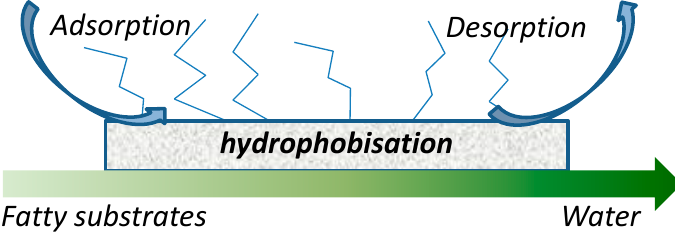
Figure 13. Preferential adsorption of fatty acids and preferential desorption of water on hydrophobic catalysts.